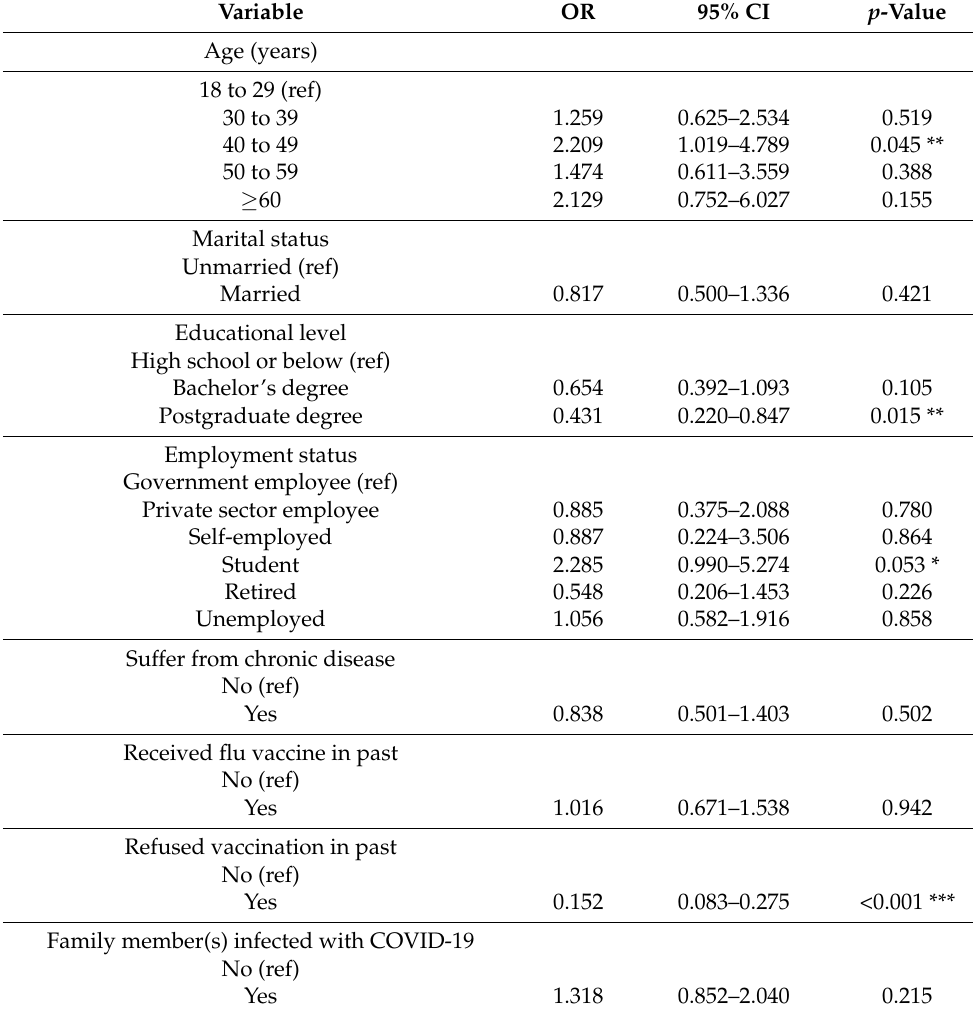
Table 2. Logistic regression estimates of factors associated with acceptance of a COVID-19 vaccine among women ( n =